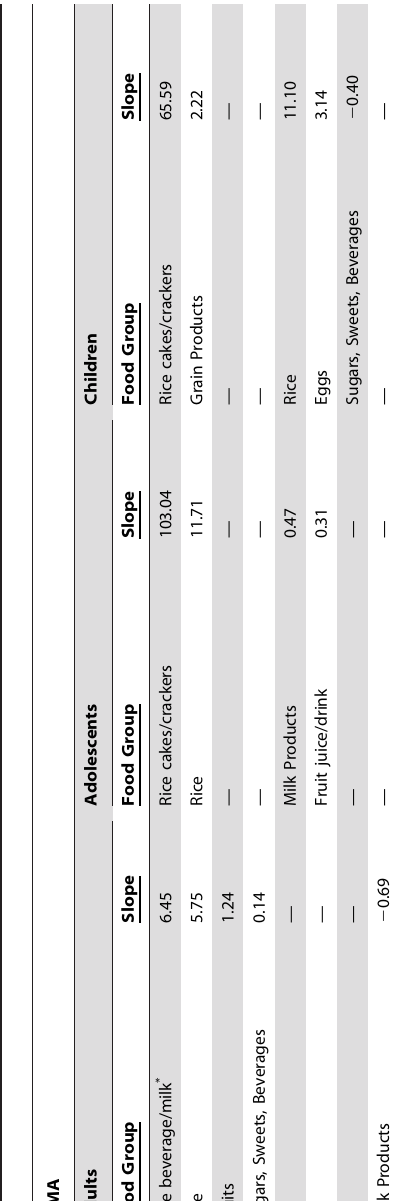
this food group. predictors in the regression models (Tables S2–S3; categorical section). Urinary creatinine was a positive and statistically significant predictor across all age strata and arsenic species. Serum folate was a significant positive predictor for DMA and MMA among adolescents. BMI was a statistically significant negative predictor for DMA among adults and for MMA among all age strata. Fasting time was a statistically significant negative predictor for DMA among adolescents and a positive predictor for DMA and MMA among adults. The largest significant increase in urinary molar concentration of methylated arsenic species was for DMA (872.55 nmol/L per kg) attributable to rice cakes/crackers consumed by adolescents (Table 4). The next largest molar increase among methylated species was associated with fish consumption among adults: 181.16 nmol DMA/L per kg. The third largest molar increase was for rice consumption among children at 115.38 nmol DMA/L per kg, followed by 105.58 nmol DMA/L per kg rice consumed by adults. At the fifth rank, MMA appears for the first time with 103.04 nmol MMA/L per kg rice cake/crackers consumed by adolescents (Table 5). The magnitude of association for the remaining food groups associated with significant increases in methylated arsenic ranged from 0.14 nmol MMA/L to 101.05 nmol DMA/L per kg for fish; fruits; grain products; legumes, nuts, seeds; meat, poultry; rice; rice cakes/crackers; rice beverage/milk (adults only); and sugars, sweets, beverages. Only one food group was associated with a significant decrease in methylated arsenic: 2 0.69 nmol MMA/L per kg milk products consumed by adults. Arsenic Exposure for the Median & 90 th Percentile Diets Arsenic species exposure [nmol/L per kg body weight (bw)] are tabulated for the median (Table 6) and 90 th percentile (Table 7) United States diets, where asterisks indicate food groups signifi- cantly associated with creatinine-adjusted changes in urinary arsenic species, as shown by the regression model slopes (Tables 4–5). The net total dietary urinary arsenic species for each age stratum is also shown. Median Diet. The net effect of all food groups on urinary arsenic can be appreciated by combining the regression slopes quantifying the contribution of each food group to urinary arsenic with information on the amount of each food group consumed. m p For the methylated arsenic species, children (1.28E-2 nmol T C o MMA/L per kg bw), adolescents (9.32E-3 nmol DMA/L and